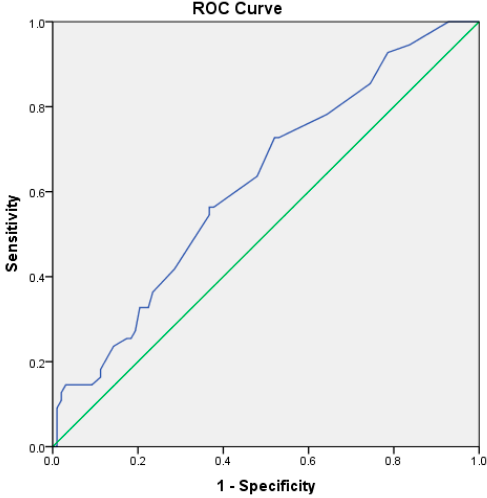
Figure 4. ROC curve for procalcitonin and in-hospital mortality (blue line—ROC curve, green line—reference line).